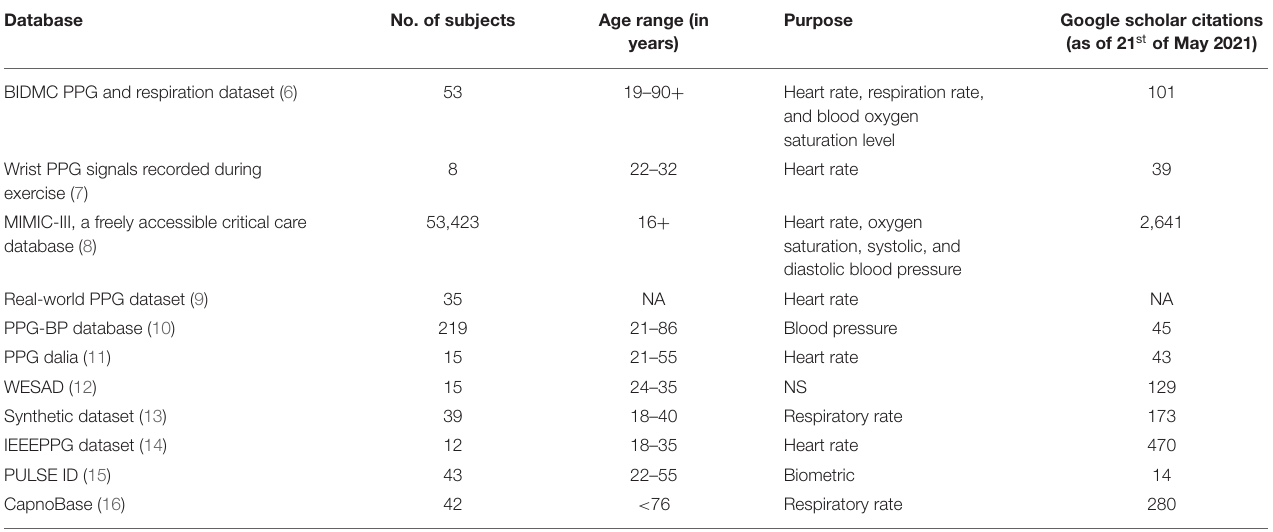
TABLE 1 | Details of different publicly available pulse oximeter databases.